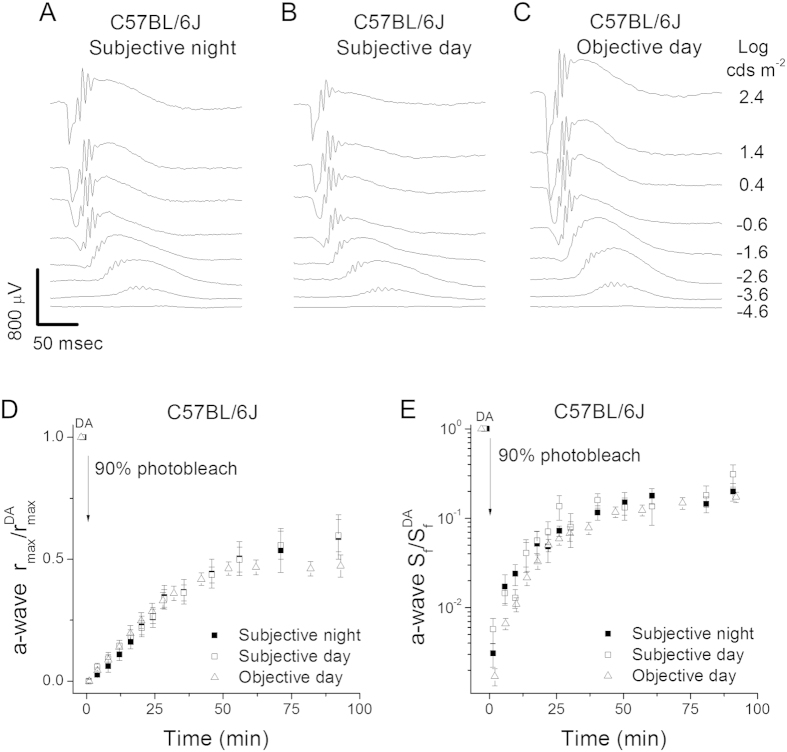
Lack of effect by the circadian clock and light history on rod dark adaptation in melatonin-deficient C57BL/6 J mice.Representative scotopic in vivo ERG responses to various light intensities from C57BL/6J mice at (A) subjective night, (B) subjective day, and (C) objective day. (D) Normalized in vivo ERG scotopic a-wave maximal response (a-wave rmax/a-wave rDAmax) recovery in C57BL/6J mice following 90% pigment bleach at t = 0 at subjective night (solid squares, n = 7), subjective day (open squares, n = 6), and objective day (open triangles, n = 10). (E) Normalized in vivo ERG scotopic a-wave sensitivity (a-wave Sf/a-wave SfDA) recovery in C57BL/6J mice following 90% pigment bleach at t = 0 at subjective night (solid squares, n = 7), subjective day (open squares, n = 6), and objective day (open triangles, n = 10).